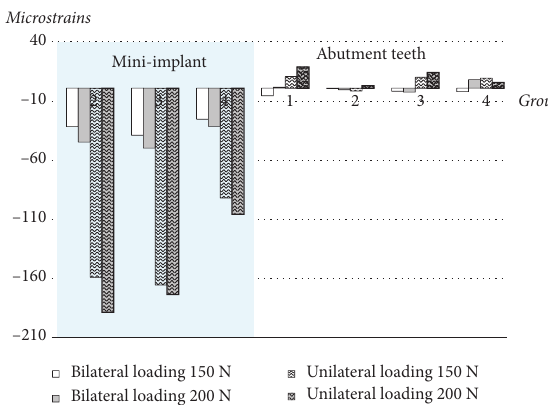
Figure 4: Comparison of microstrains around abutment teeth and dental mini-implants in all loading conditions with 150N and 200N bilateral and